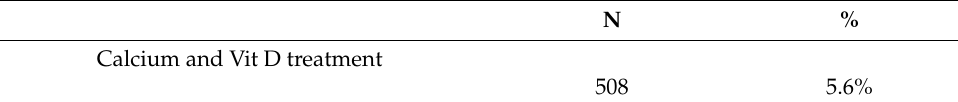
Table 1. Cont. Calcium and Vit D treatment